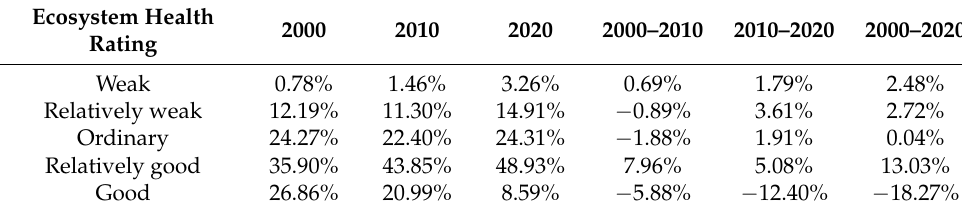
Table 4. Percentage area and relative change in EHI values in the GBA, 2000–2020.